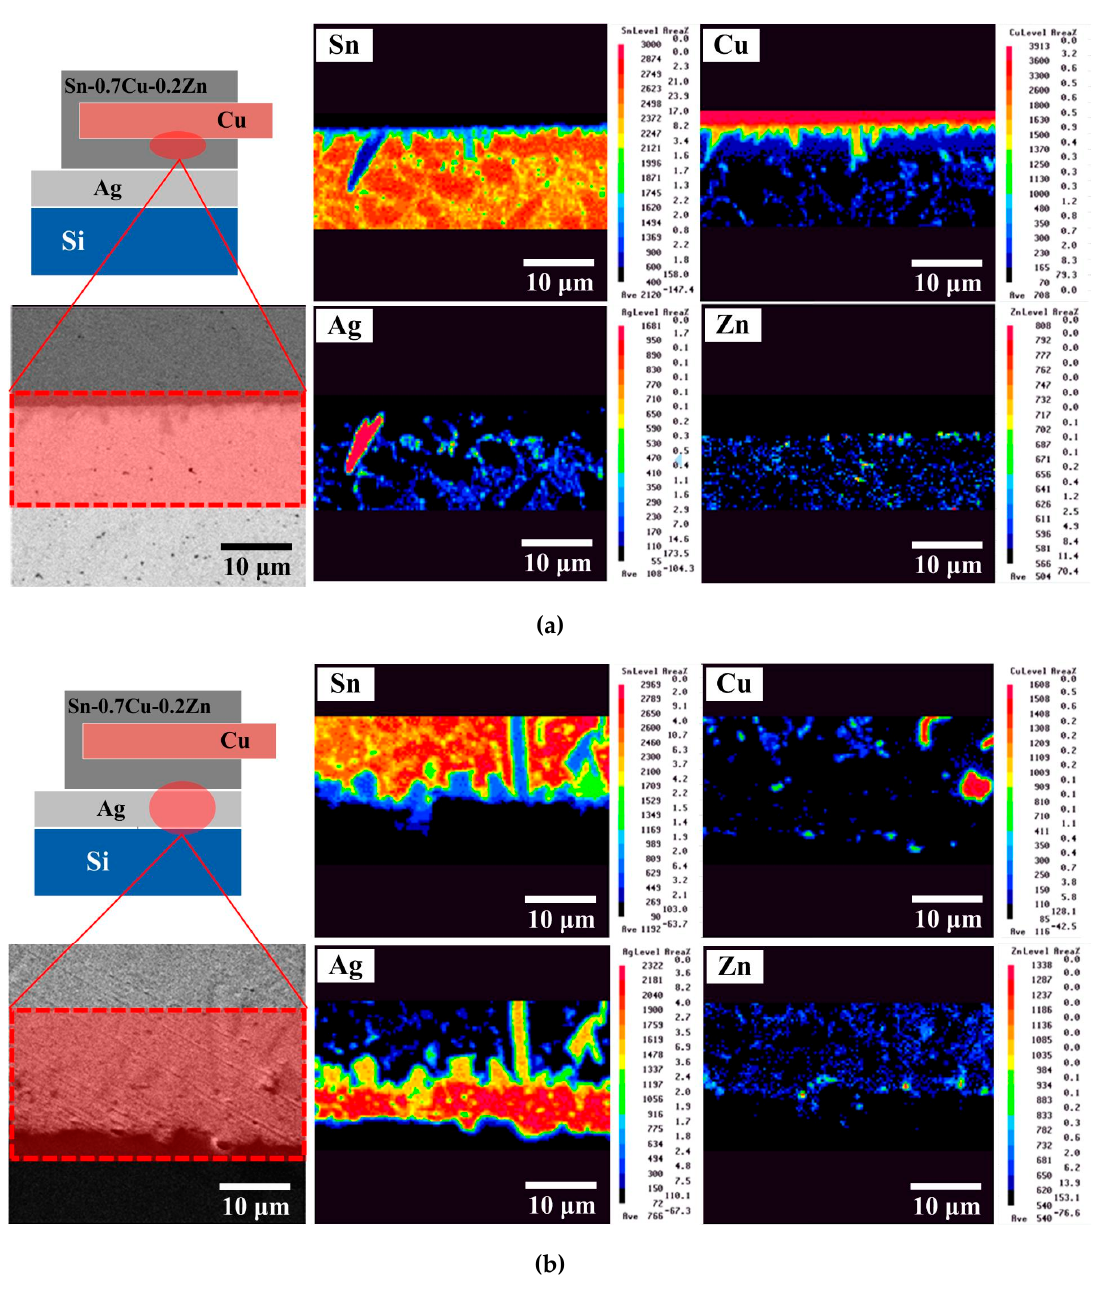
Figure 4. EPMA images of the biased Sn–0.7Cu–0.2Zn PV module at the ( a ) Cu / solder and ( b ) solder / Ag interfacial regions.